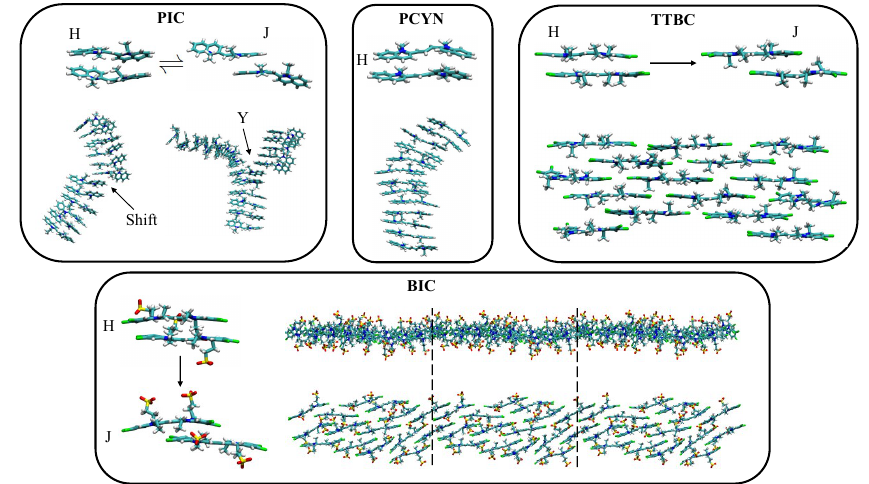
Figure 11. ( Top left ): H and J aggregate structures for PIC, plus shift defects and Y-defects seen in large aggregates. ( Top middle ): H aggregate structures for PCYN. ( Top right ): H and J aggregate structures for TTBC and a brick-like layer structure seen for TTBC at high concentrations, where J-aggregation dominates over H-aggregation. ( Bottom ): H and J aggregate structures for BIC and a layer structure observed for BIC molecules (side and top view). Figure adapted from Ref. [107], 2021 CC-BY licence, with permission from the Royal Society of